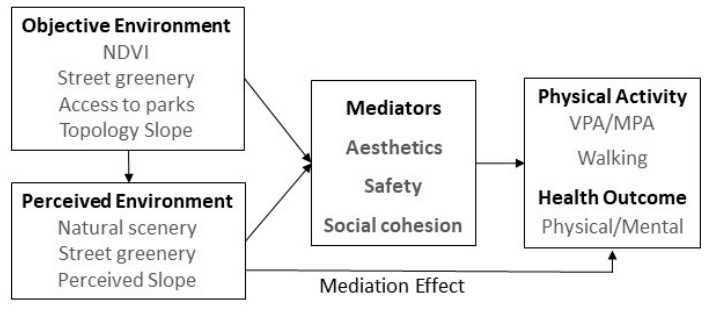
Figure 1. Conceptual framework.